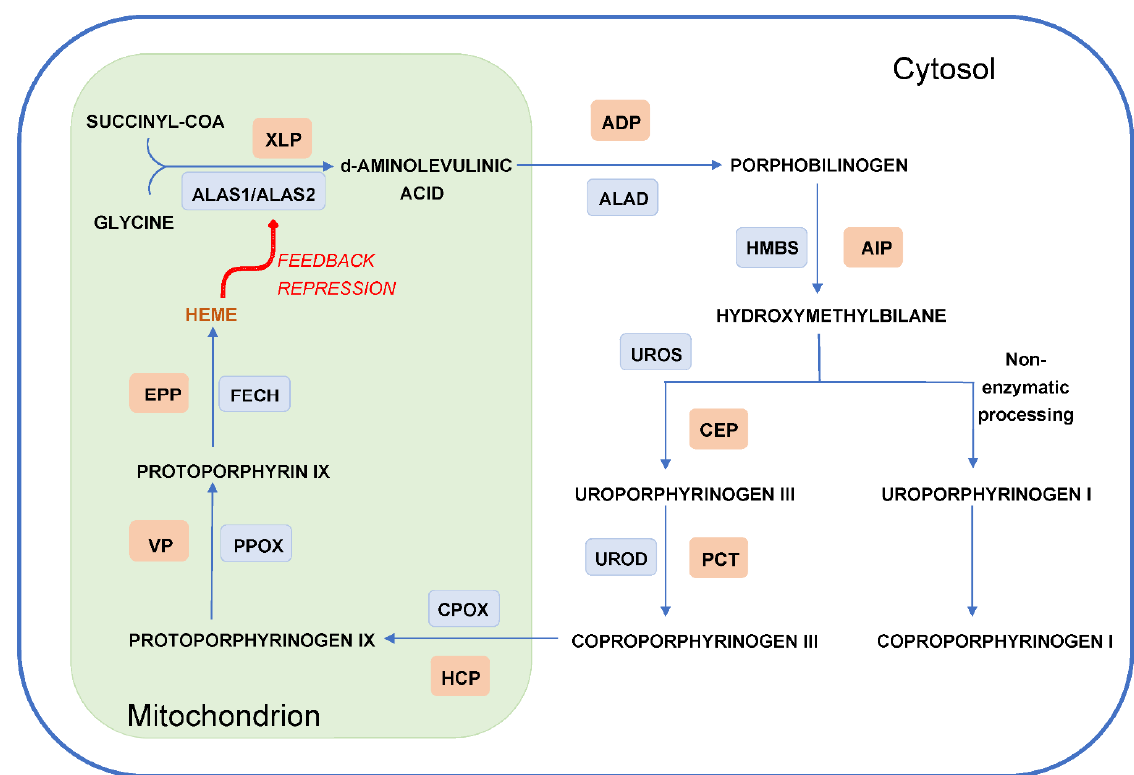
Figure 1. The heme biosynthetic pathway: Eight enzymatic steps lead to the conversion of succinyl-CoA and glycine to the end product, heme, which is then transported out of the mitochondrion and used for the formation of various hemoproteins. Especially in the liver, heme exerts a negative feedback on the first enzyme of the heme biosynthetic pathway, ALAS1. While ALAS1 is ubiquitously expressed, its isoform, ALAS2, is erythroid specific and is regulated by erythroid-specific transcription factors. Four catalytic reactions of the heme biosynthetic pathway occur in the mitochondrion and the other four steps in the cytosol. Dysfunction of each enzyme (in blue boxes) results in a different type of porphyria (in red boxes) due to accumulation of the different heme precursors and porphyrins in various tissues. Abbreviations: enzymes of the heme biosynthetic pathway: ALAS1/ALAS2, delta-aminolevulinic acid synthase 1/2; ALAD, delta-aminolevulinic acid dehydratase; HMBS, hydroxymethylbilane synthase; UROS, uroporphyrinogen III synthase; UROD, uroporphyrinogen decarboxylase; CPOX, coproporphyrinogen oxidase; PPOX, protoporphyrinogen oxidase; FECH, ferrochelatase. Different types of porphyria: XLP, X-linked protoporphyria; ADP, delta-aminolevulinic acid dehydratase deficiency porphyria; AIP, acute intermittent porphyria; CEP, Congenital erythropoietic porphyria; PCT, porphyria cutanea tarda; HCP, hereditary coproporphyria; VP variegate porphyria; EPP, erythropoietic